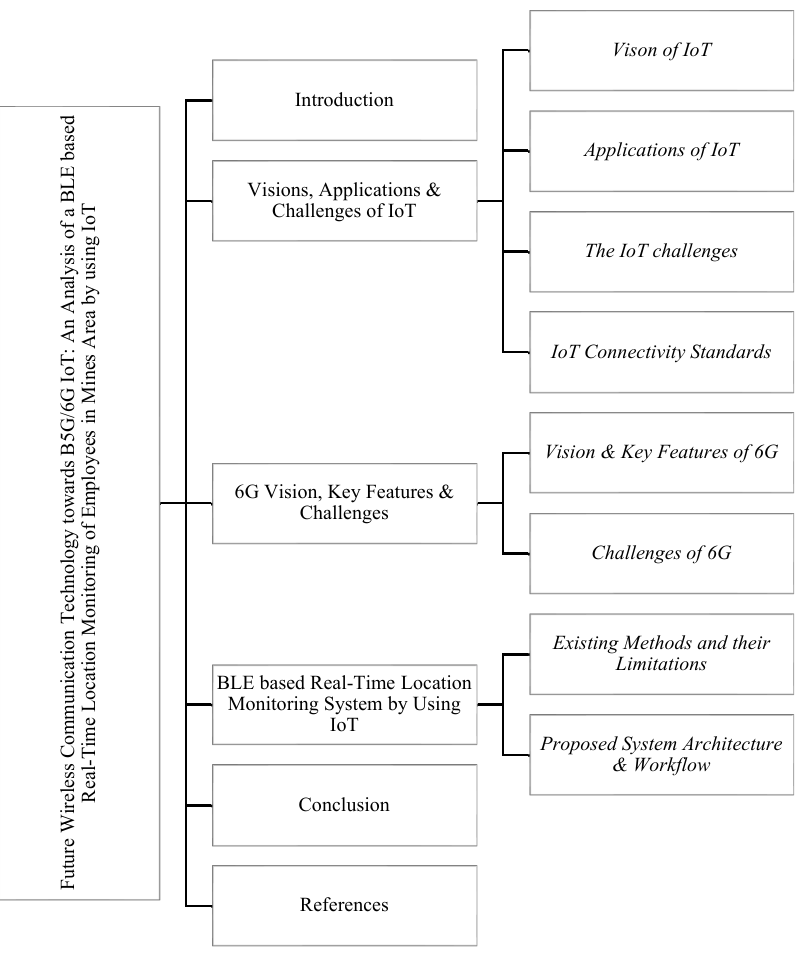
Figure 2. Structure of the Paper.